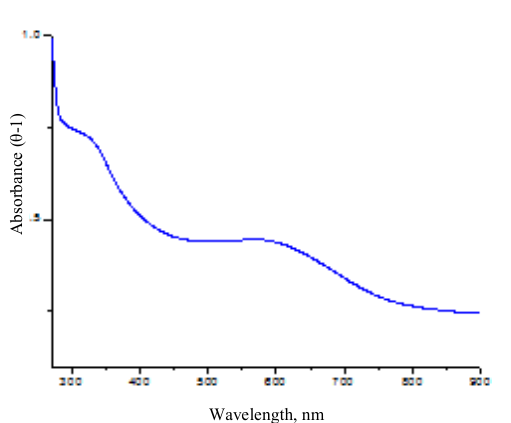
Figure 2. UV-Visible spectrum of PTSA doped tetrananiline prepared at a molar ratio of N -phenyl-1, 4-phenylenediamine to PTSA for 1:5.